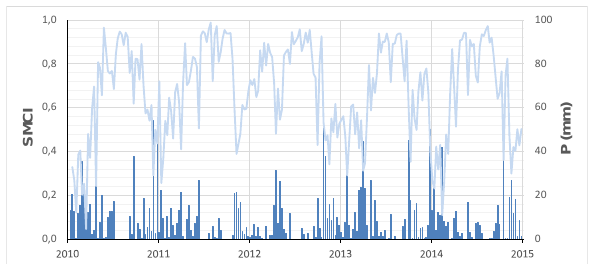
Figure 4. Temporal cycle of SMCI and rainfall evolution in REMEDHUS